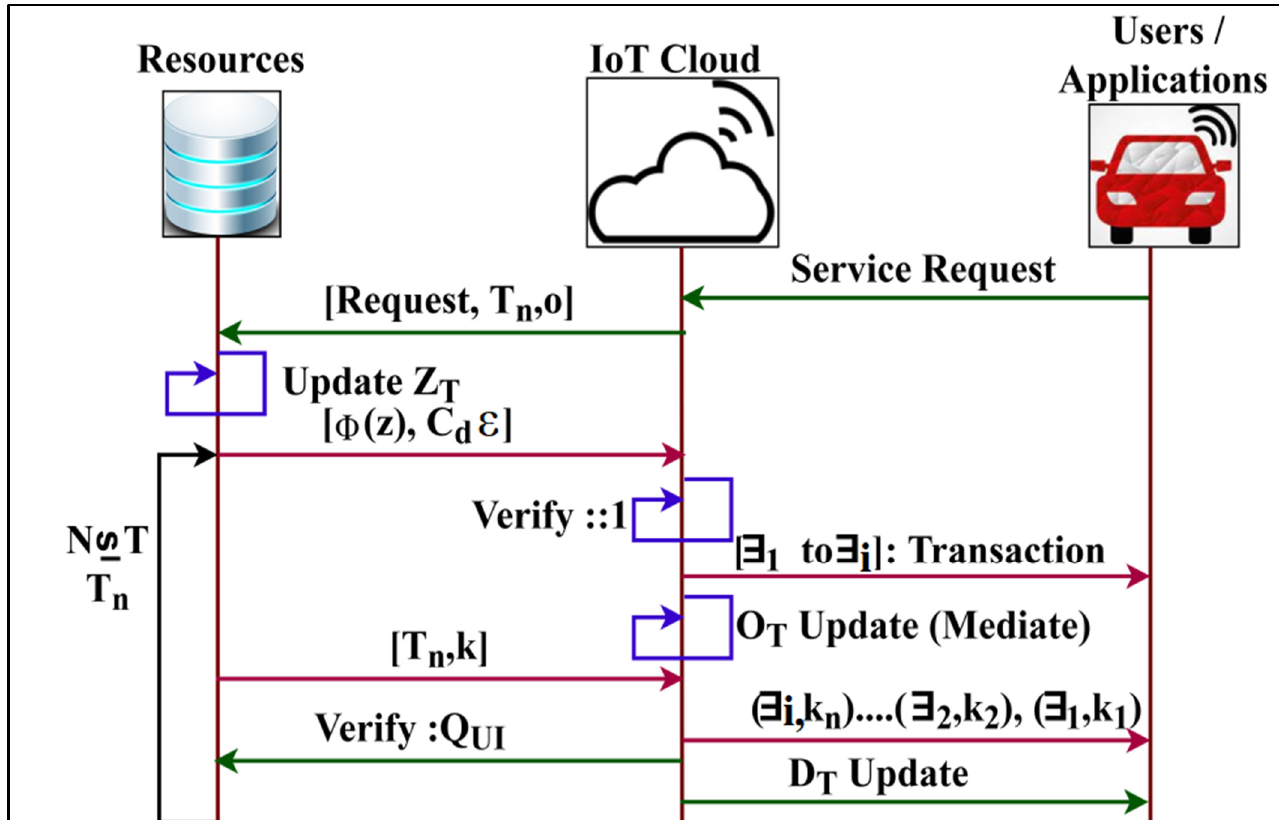
Figure 3. Key generation process in T (cid:2924)